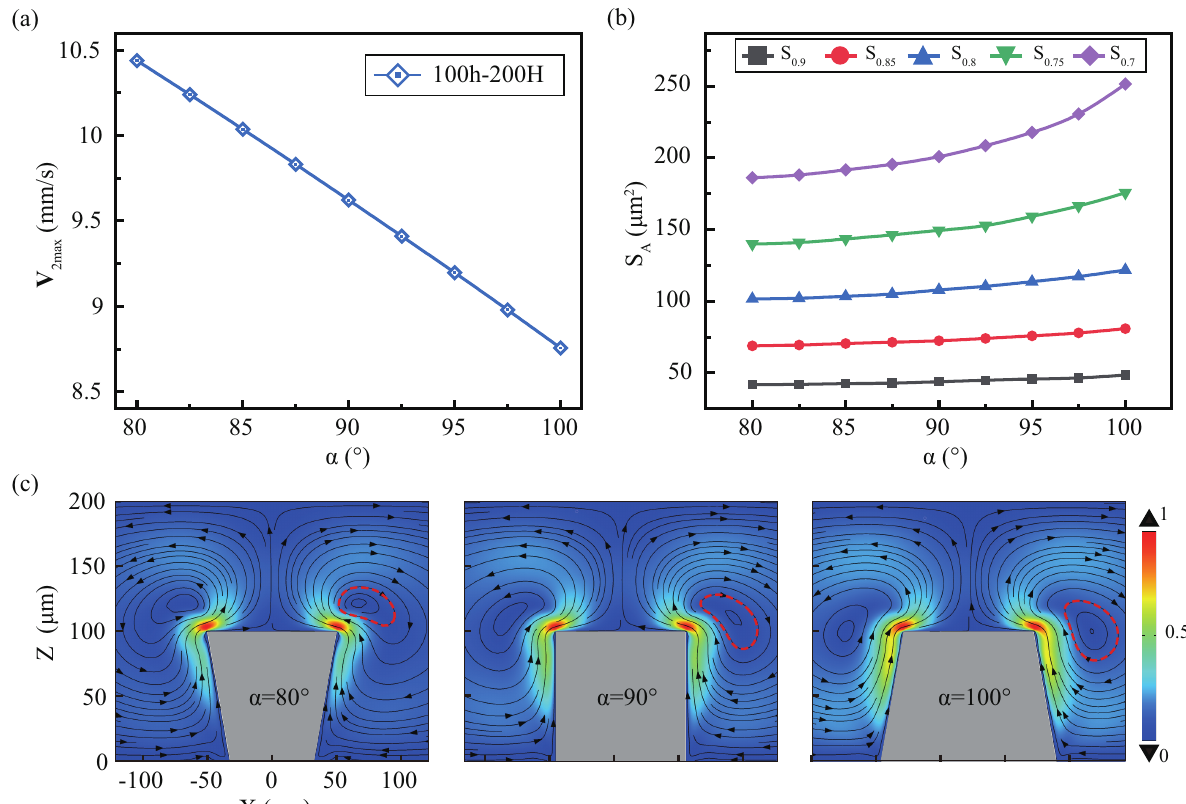
Figure 6. The effect of the microstructure sidewall profile’s angle α on the streaming. Under fixed microstructure conditions of h = 100 µ m and H = 200 µ m, the angle α effect on ( a ) maximum speed, ( b ) effective areas, and ( c ) mode where the red dotted line represents the streaming was studied. The legend of each cloud atlas divided by the respective maximum streaming